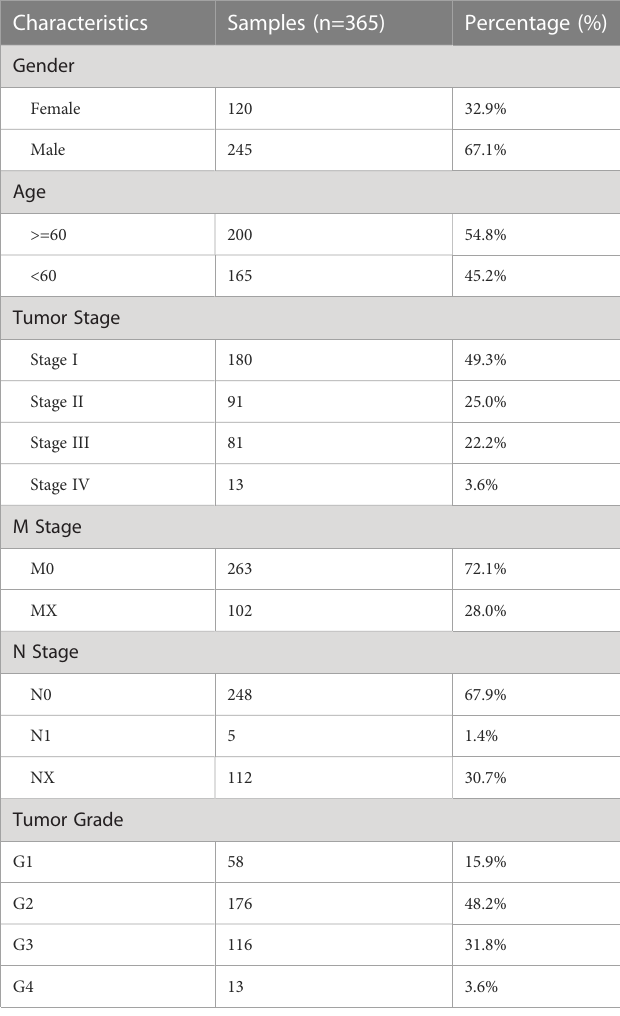
TABLE 1 Clinical characteristics of 365 HCC patients in TCGA LIHC.